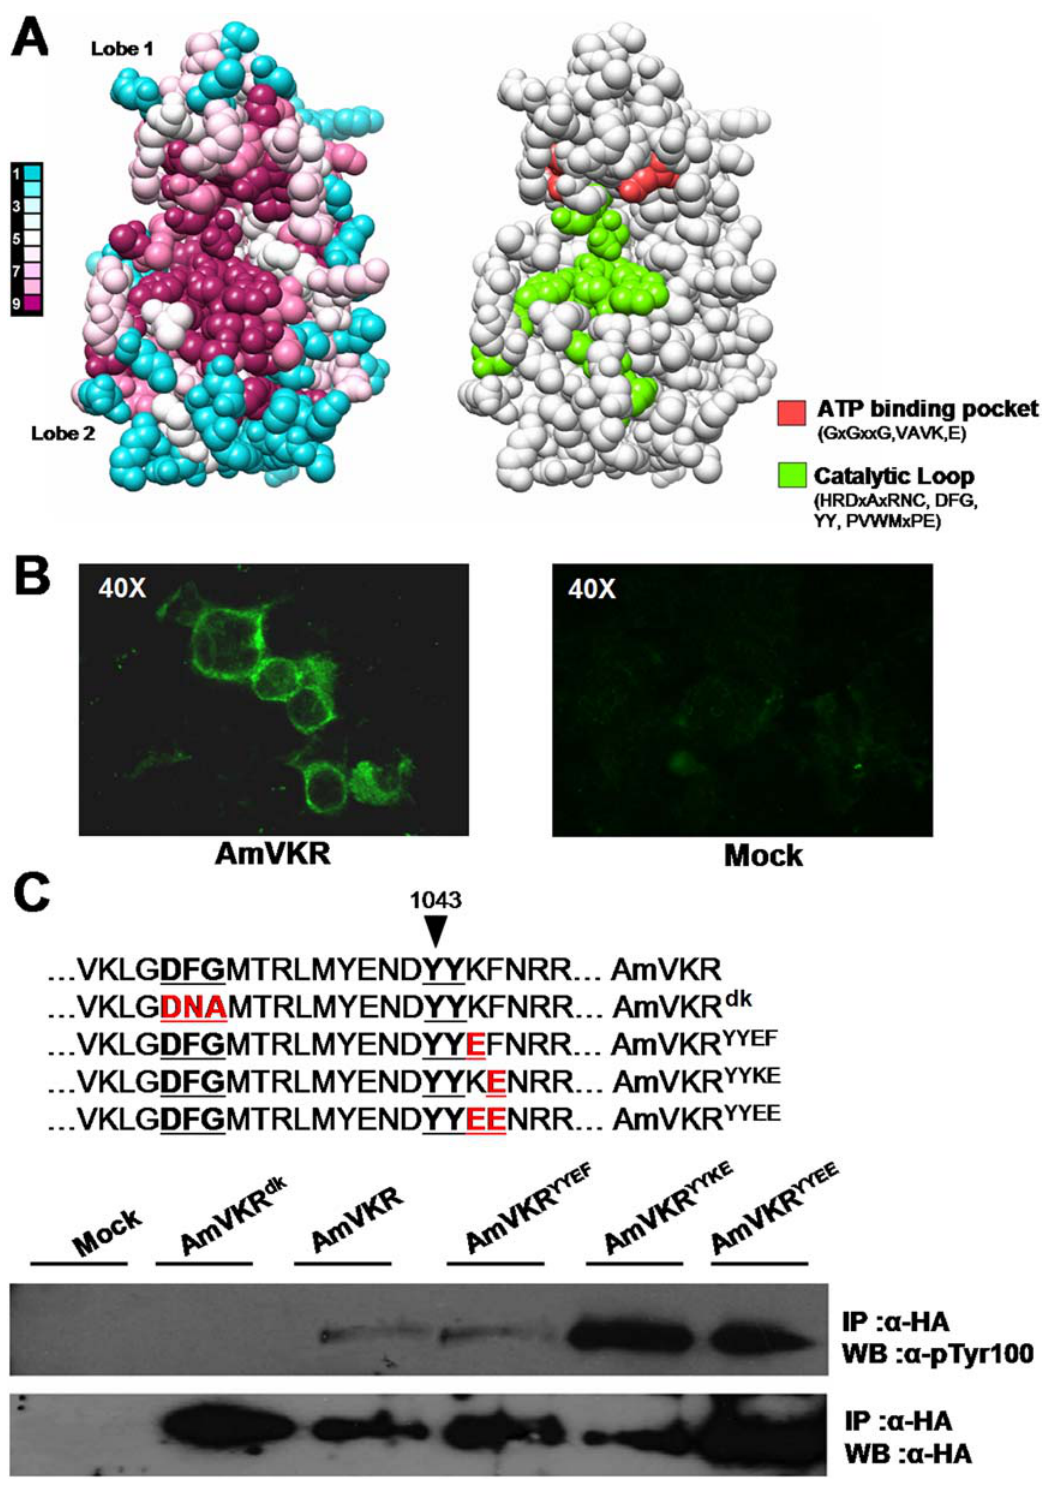
Figure 7. AmVKR shows tyrosine kinase activity. A- Evolutionary conservation of residues of the VKR TK domain (left panel) visualized on the human IR TK crystal structure (PDB accession number 1IR3). Conservation scores are according to a color scale from variable (blue) to conserved (purple) residues. For comparison, the crucial residues needed for kinase activity (right panel) are indicated. B- Expression of the HA-tagged AmVKR in HEK-293 transfected cells revealed by anti-HA antibodies. C- Tyrosine kinase activity of HA-tagged AmVKR proteins. Lysates from HEK293 cells transfected by plasmids containing AmVKR or mutated versions of AmVKR, or by empty prk5 plasmid as a control, were immunoprecipitated by anti- HA antibodies. Kinase assays were performed as described in Materials and Methods. Proteins were analysed by Western blot and tyrosine phosphorylation was detected using P-Tyr-100 antibodies.